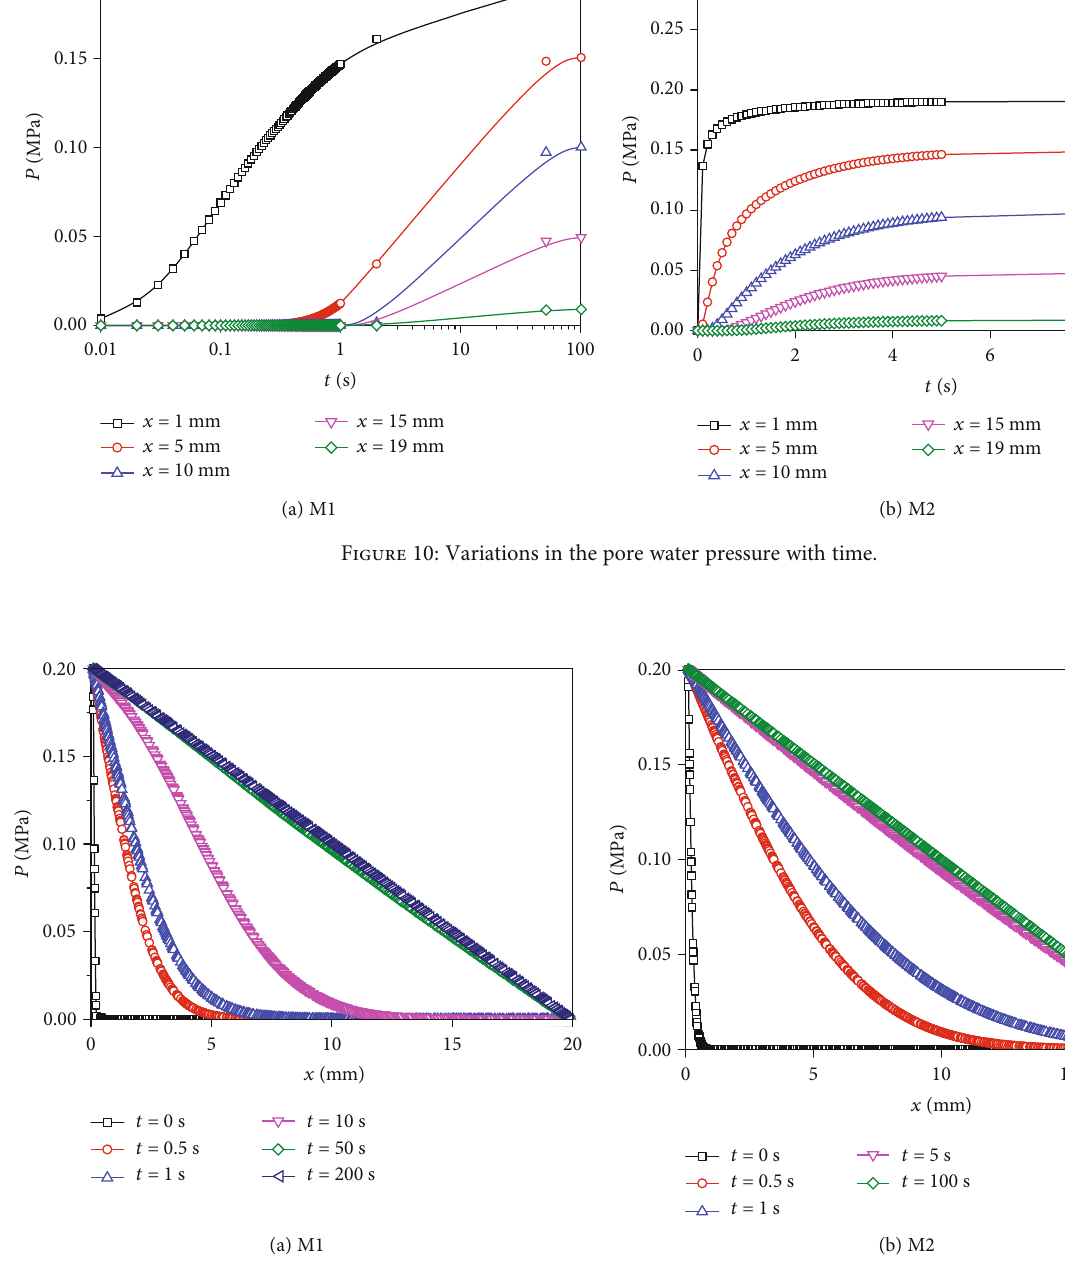
Figure 11: Variations of the pore water pressure along the fracture